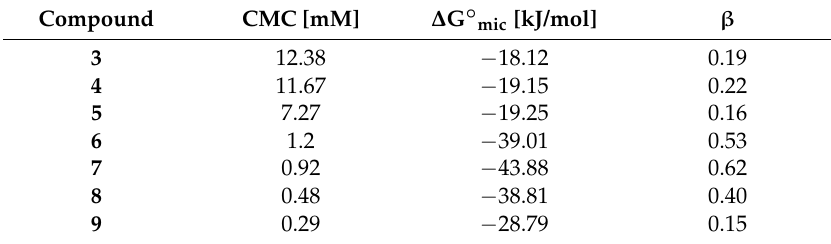
Table 3. Critical micelle concentration (CMC), counterion binding parameter ( β ) and Gibbs free energy of micellization ( ∆ G ◦ mic ) of compounds ( 3 – 9 ) obtained by conductivity measurements. Compound CMC [mM]